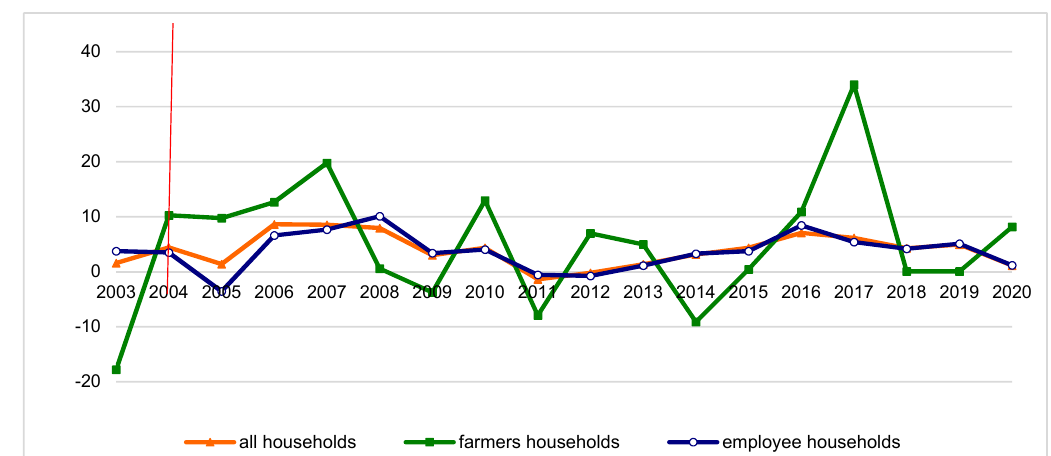
Figure 2. Annual growth rates of real available income in farmers’ households in 2003–2020 as compared to the income of employees and total households (in %). Source: as Figure 1. Note: 2004—Poland joins the EU and agriculture is covered by CAP instruments.